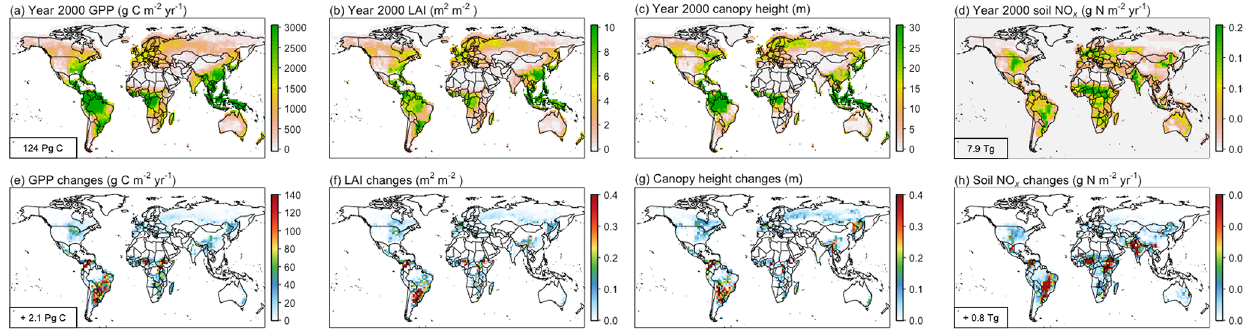
Figure 4. Annual mean of year 2000 (a) gross primary production (GPP), (b) leaf area index (LAI), (c) canopy height, and (d) soil NO x emission and the corresponding increases (e–h) due to increased nitrogen deposition over year 2000 to year